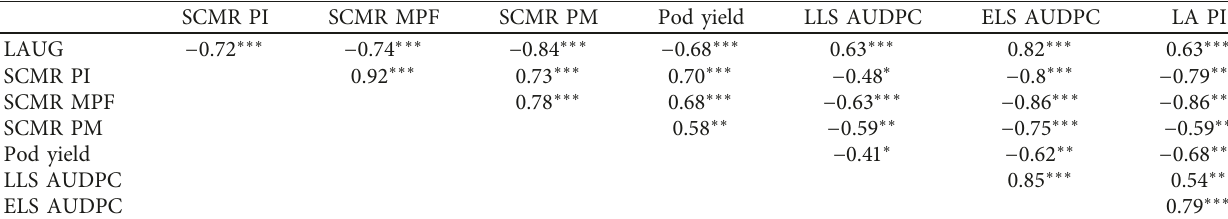
Table 6: Correlation between pod yield, SCMR, LA, ELS AUDPC, and LLS AUDPC. SCMR PI